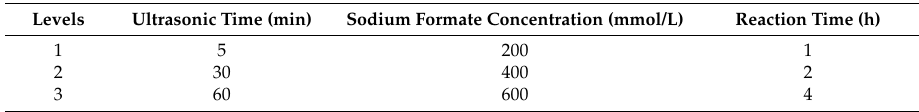
Table 1. Orthogonal design of three factors and three levels.